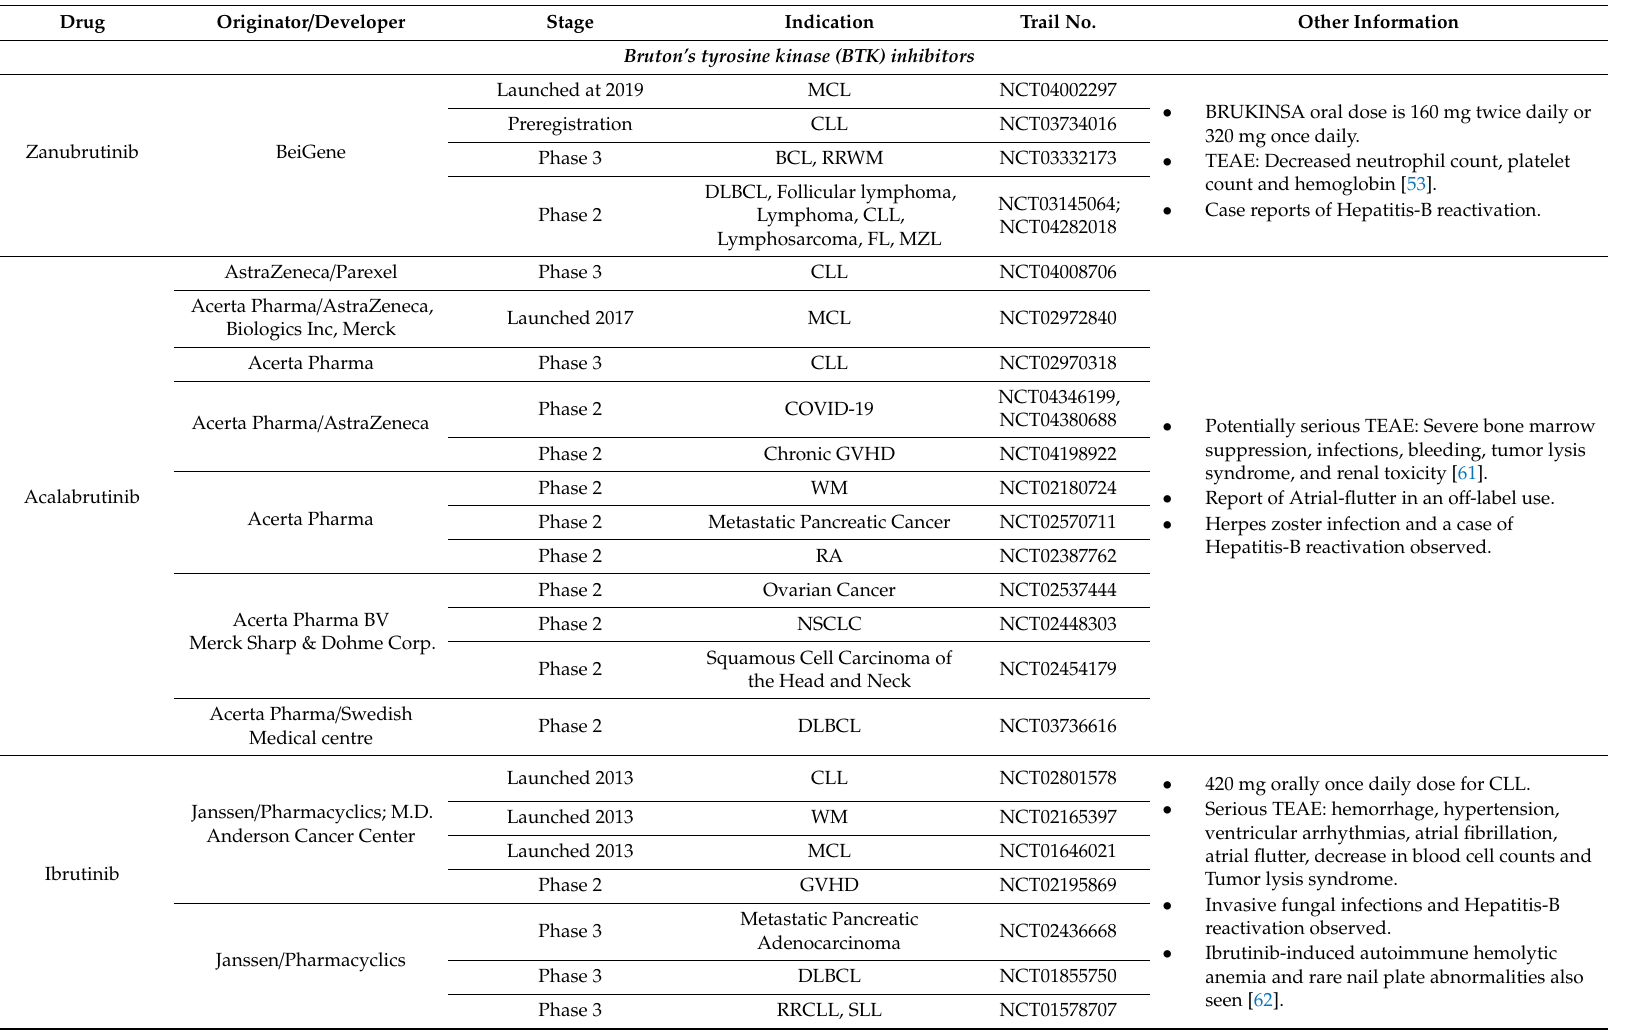
Table 2. Clinical small molecule inhibitors of cellular receptors adaptor protein in NF-kB